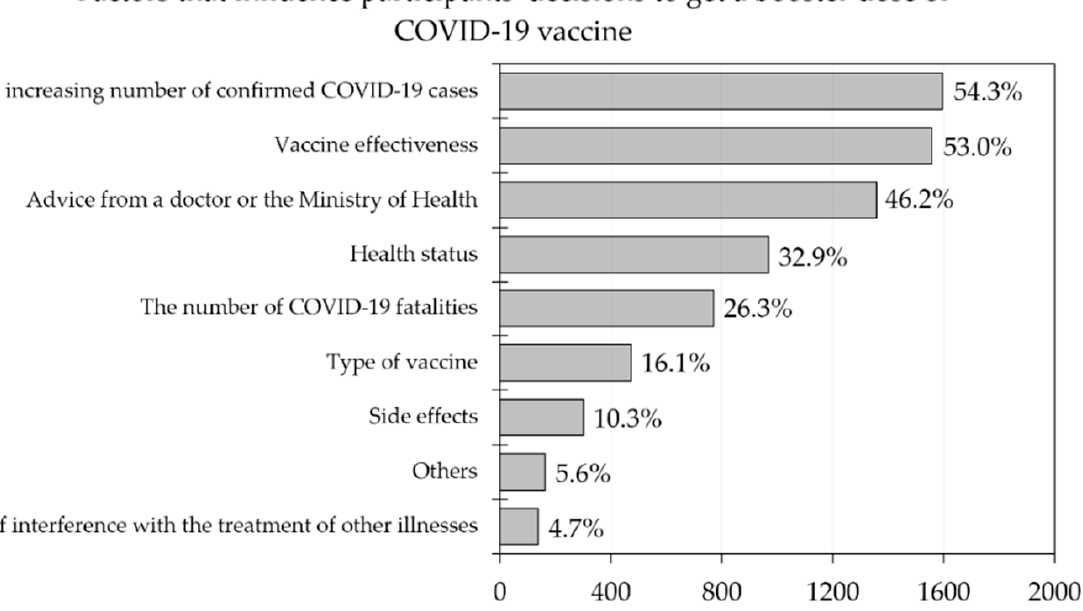
Figure 1. Reasons that motivated participants to get a booster dose of the COVID-19 vaccine ( n = 2935).